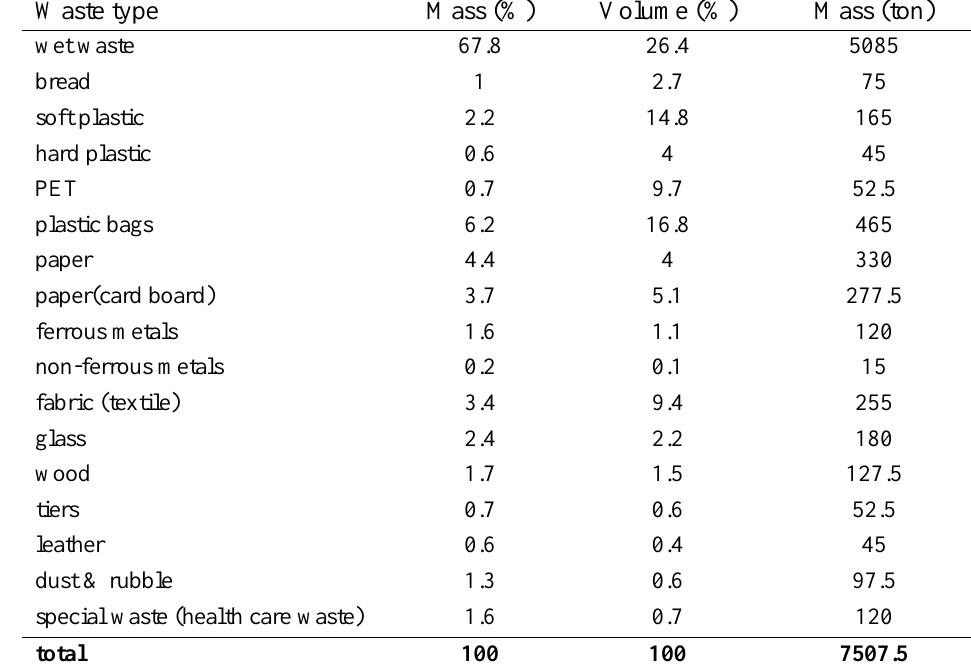
Table 1. MSW components and characteristics in Aradkuh Center (previously called